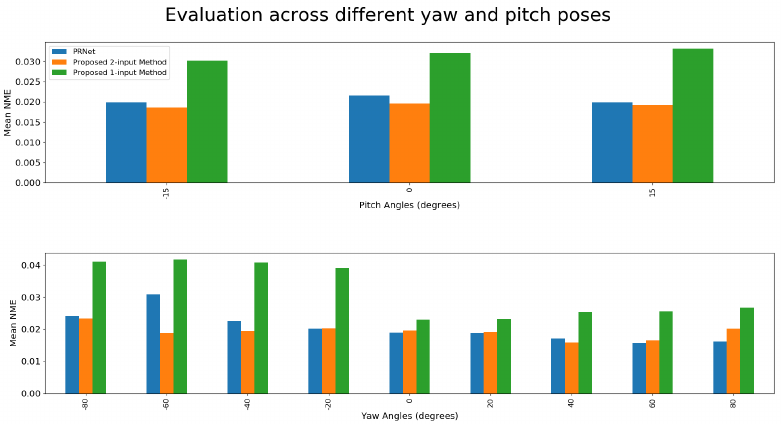
Figure 24. Mean NME of different models at different